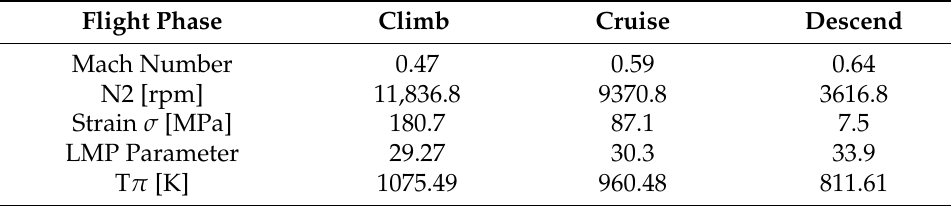
Table 6. EMB-135 mission creep main results.